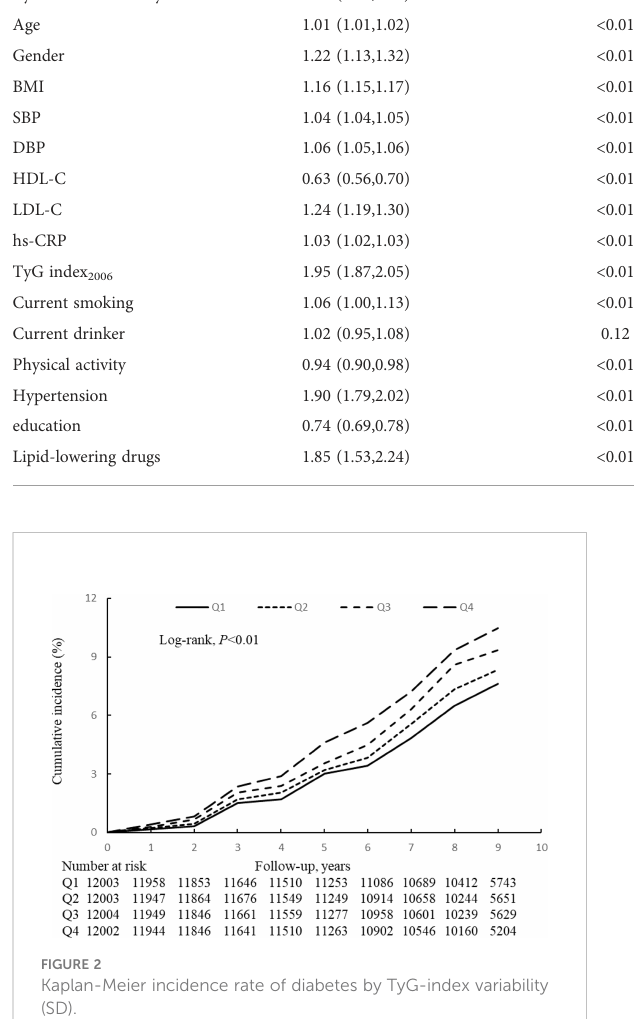
FIGURE 3 Sensitivity analysis of the association of TyG index variability with incident diabetes according to other indices of TyG-index variability (Average Real Variability, Coef fi cient of Variation, Variability Independent of the Mean) replacing Standard Deviation the in all the models. Model adjusted for age, sex, LDL-C, HDL-C, hs-CRP, BMI, smoking status, alcohol consumption status, physical exercise habits, educational level, hypertension, the use of lipid-lowering drugs, and TyG